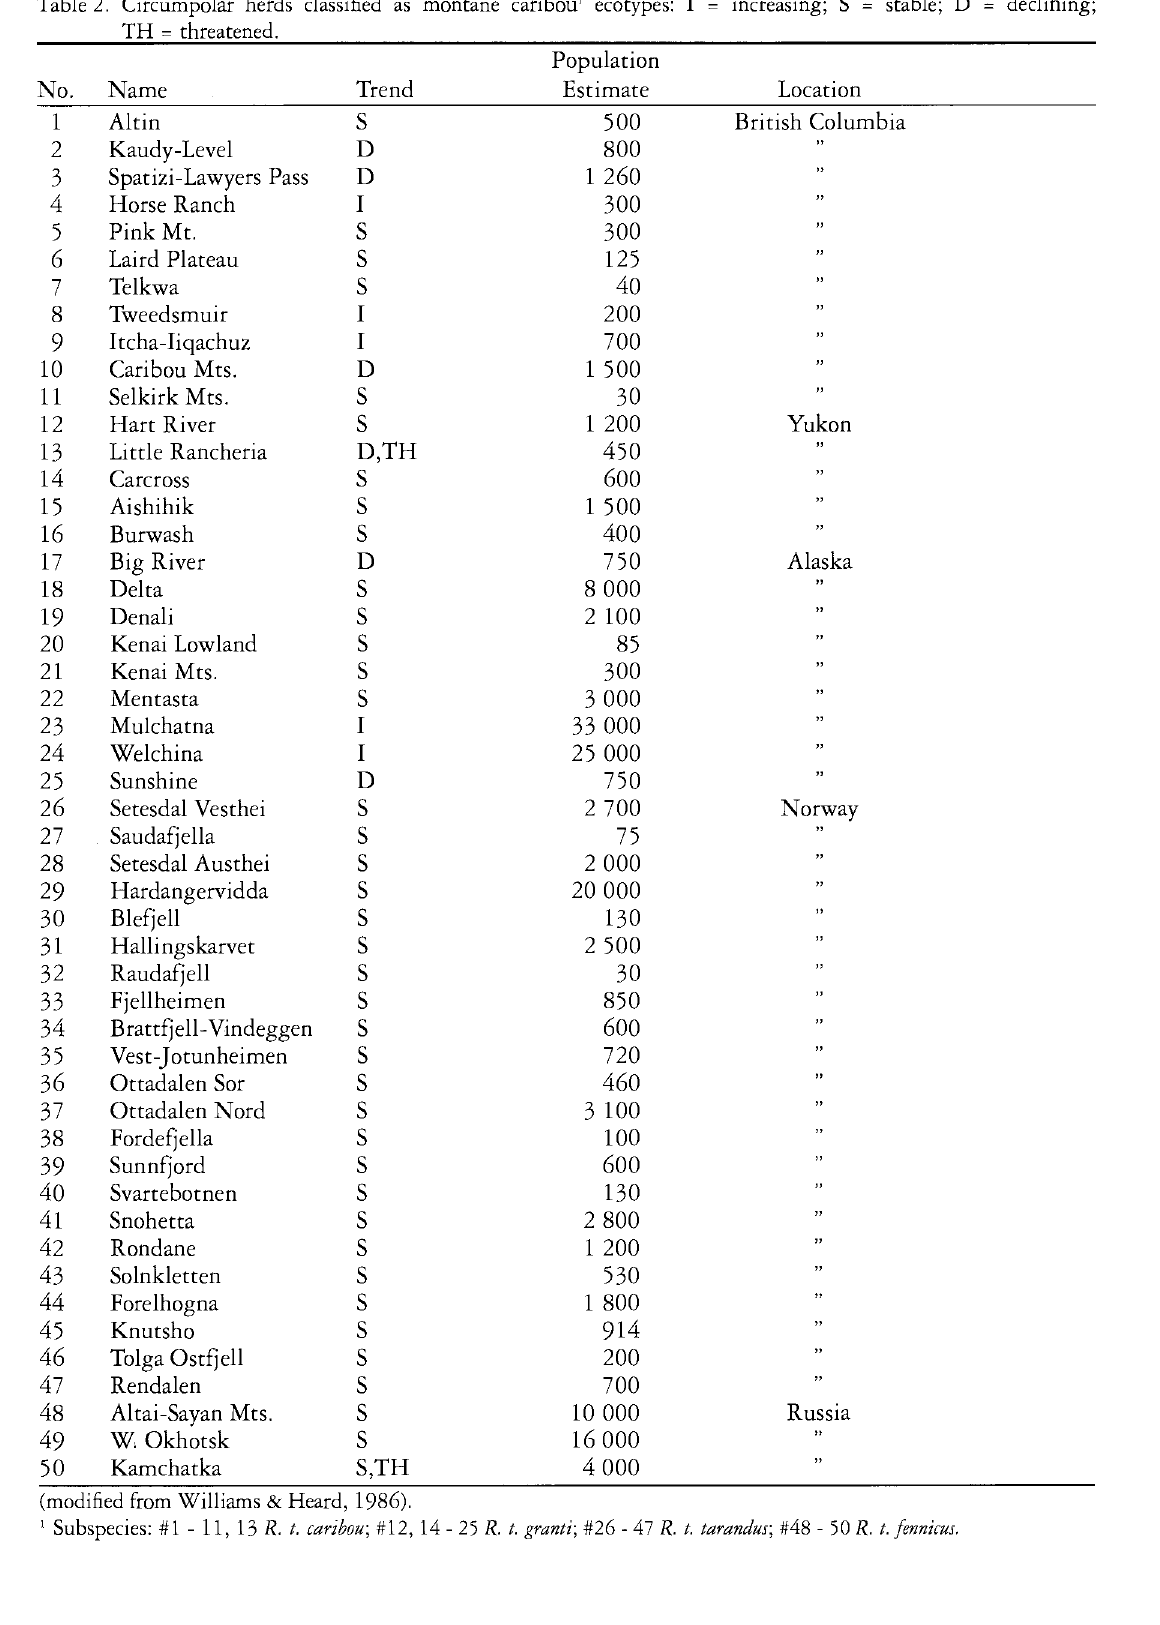
Table 2. Circumpolar herds classified as montane TH =